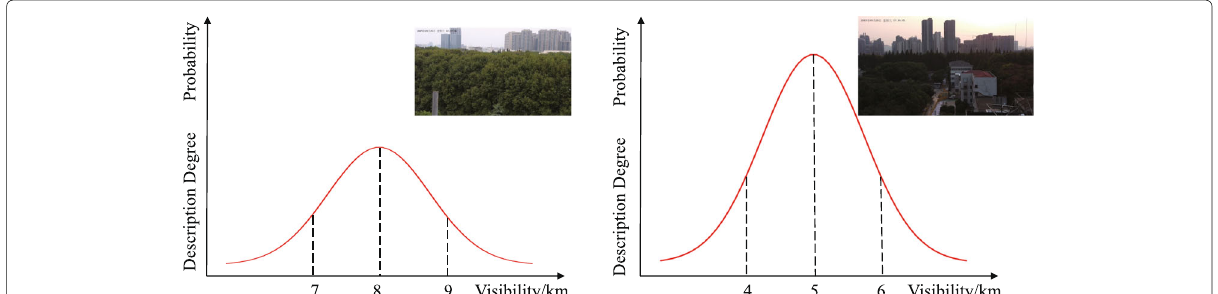
Fig. 1 Our method labels the image visibility as a probability